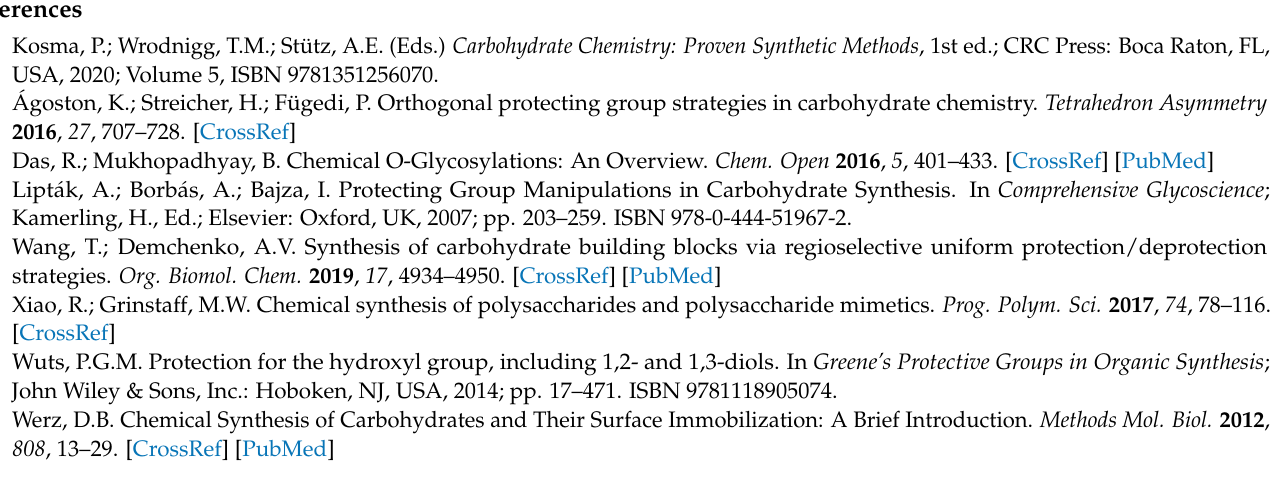
Figure S5: Me-profiles and DS values of MC-1 based on the oligomer analysis by LC-MS; Figure S6: Me-profiles and DS values of MC-2 based on the oligomer analysis by LC-MS; Figure S7: Me-profiles and DS values of MC-3 based on the oligomer analysis by LC-MS; Figure S8: Overlay of the Me- profiles of MC 1–3 based on the oligomer analysis by LC-MS; Figure S9: ATR-IR spectra of BnMC-1, preparation procedure for quantitative LC-MS analysis of MC and deBnMC; Figure S12: LC-ESI-MS spectrum-cuout of deBnMC-1; Figure S13: Estimation of the average degree of polymerization by end-group analysis using